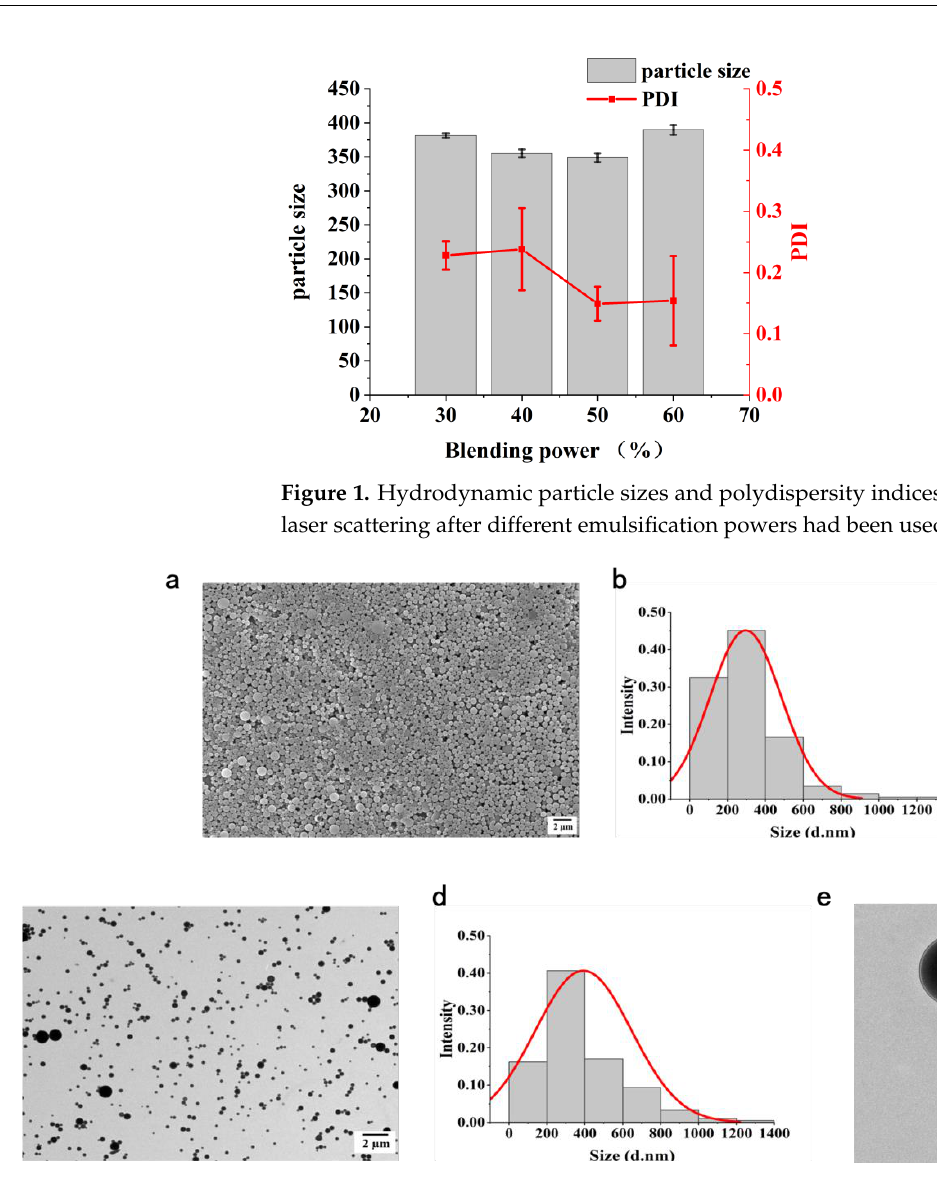
Figure 2. Electron microscopy images of the nano-microcapsules. ( a ) Scanning electron microscopy image, ( b ) size distribution based on the scanning electron microscopy data for 100 particles, ( c ) transmission electron microscopy image, ( d ) size distribution based on the transmission electron microscopy data for 100 particles, ( e ) high-magnification TEM image. The scale bars in the images indicate 1.0 µm.